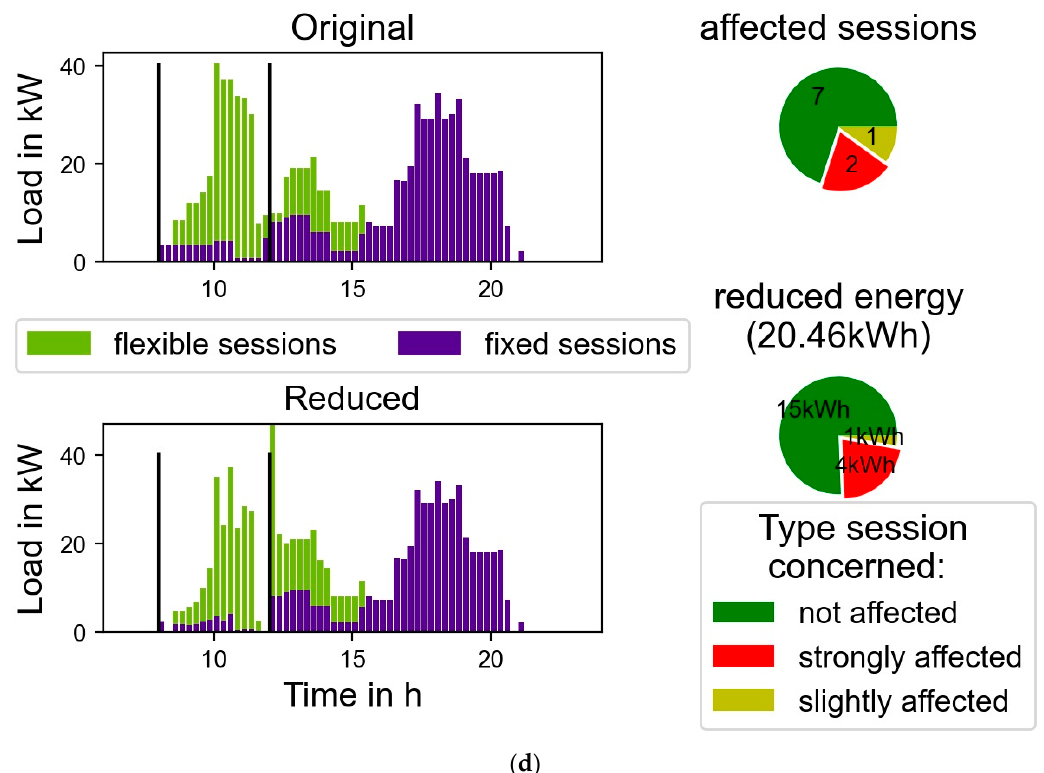
Figure 5. Optimal schedules of load reduction during a single day with a window of four hours (marked in purple). The upper left parts illustrate the original load curve and the lower left parts the reduced load curve. The flexible sessions are marked in red and the non-flexible charging sessions in green. The purple lines show the time window of the load reduction. The right side shows the impact of load reduction on the customers: ( a ) Car park; ( b ) Office; ( c ) Residential; ( d ) Shopping center.